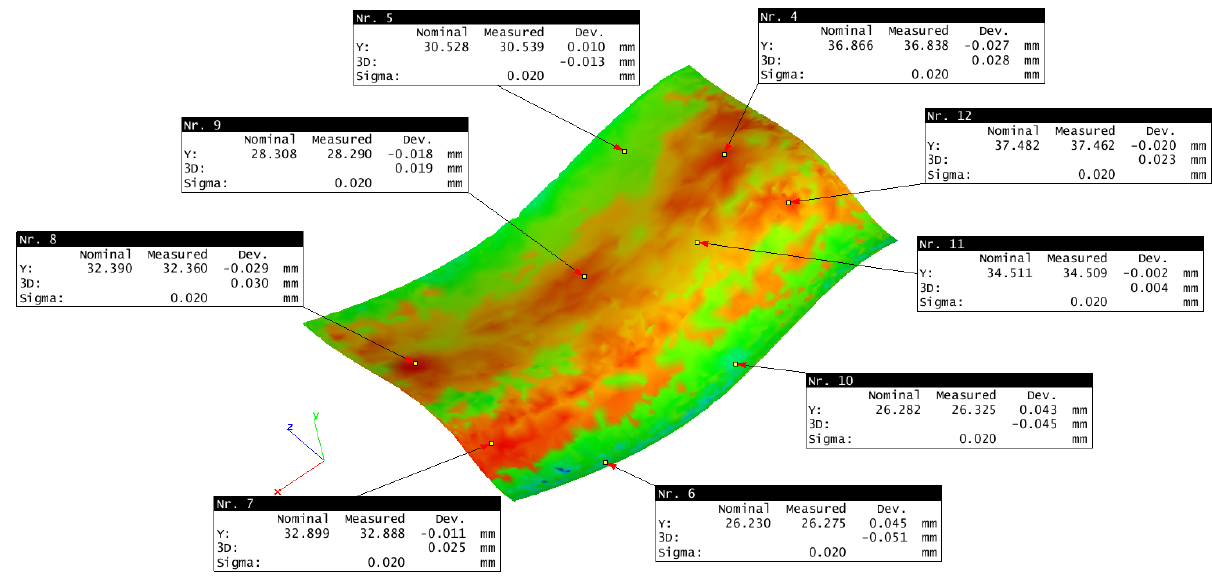
Figure 14. Numerical form deviation of randomly selected points for